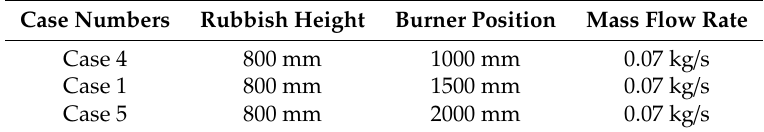
Figure 12. Velocity contours inside the primary and secondary chambers of the incinerator (m/s).